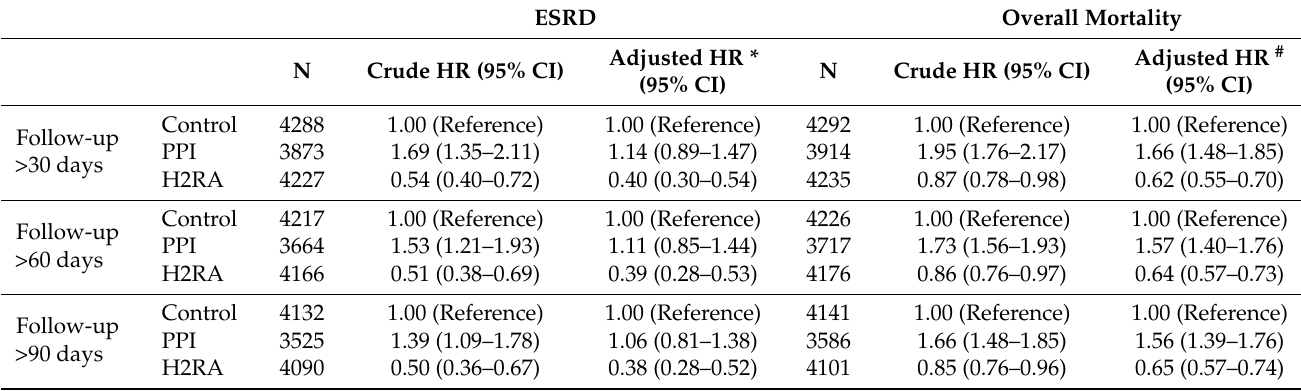
Table 6. Risks of study outcomes in CKD patients excluding dying or developing ESRD within 30, 60, and 90 day after the index